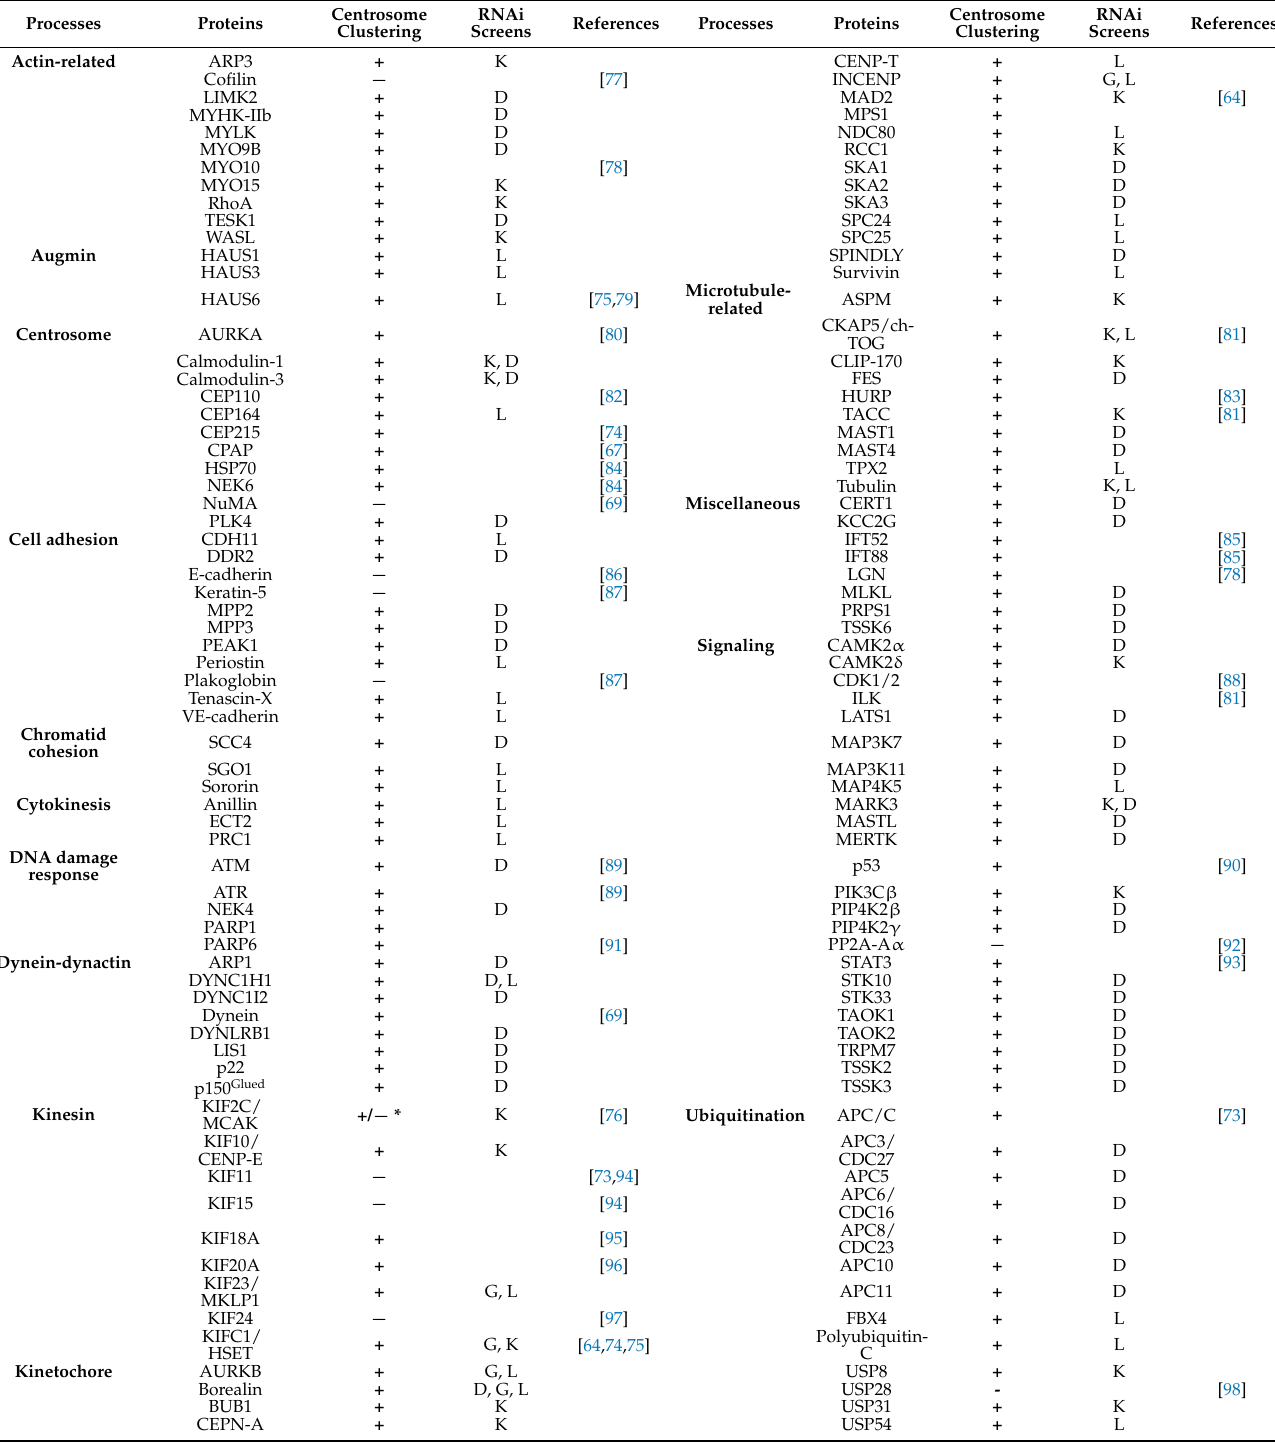
Table 1. Regulators of clustering of supernumerary